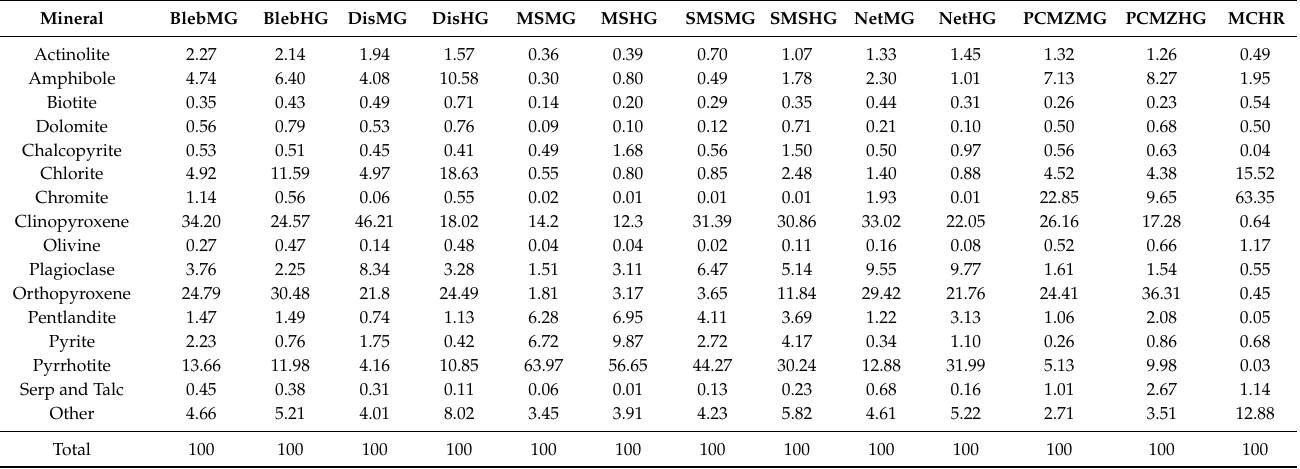
Table 4. Mineral modal abundances of samples of the MMZ and PCMZ ore horizons (area % for ore crushed to − 2 mm).